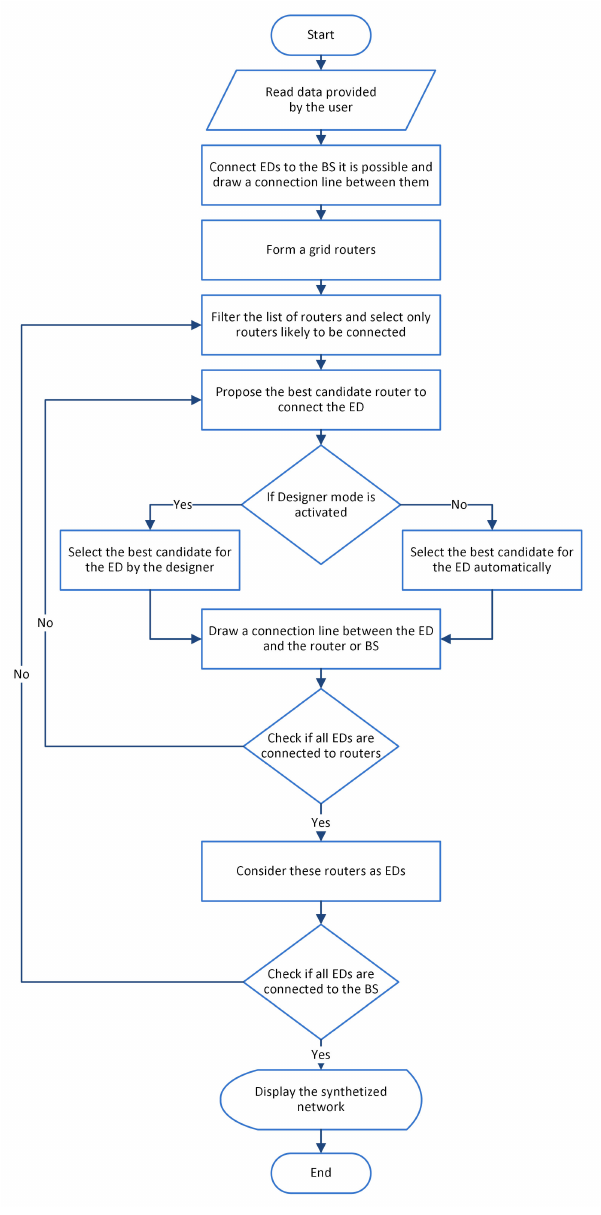
Figure 1. Flowchart of the proposed